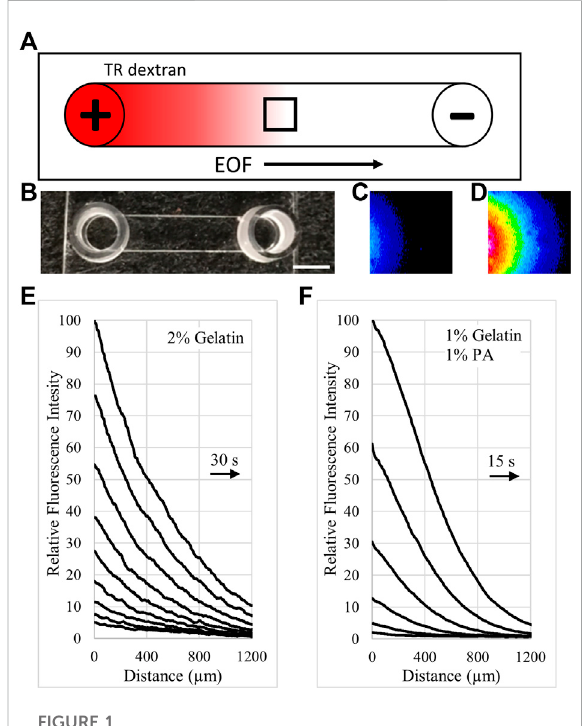
FIGURE 1 Tracking EOF rates with neutral fl uorescent dextran. (A) . Illustration (top view) of an IBIDI channel with fl uorescent, neutral Texas Red (TR) dextran loaded into the anode (+) well. The dye front moved with EOF toward the cathode (-) and was tracked to calculate EOF rate. The small black box indicates the fi eld of view during imaging. (B) . Photo of an empty IBIDI channel with scale bar = 4 mm. (C) . Pseudocolor image of the dye front entering the left side of the fi eld of view for a 1% gelatin, 1% PA gel. The pseudocolor scale uses the colors of the rainbow with dim fl uorescence (blue) and bright fl uorescence (red) (D) . Pseudocolor image of the dye front acquired 45 s after the image in (C) . (E) . Relative intensity pro fi lesof thecathodemovingdyefrontthrough 2% crosslinked gelatin are reported in 30 s intervals. Right pointing arrow indicates the direction of the moving dye front. (F) . Relative intensity pro fi les of the dye front through a 1% gelatin, 1% polyacrylate mixture arecoveringgreaterdistancein 15 sintervals. Arrow indicates the direction of the moving dye